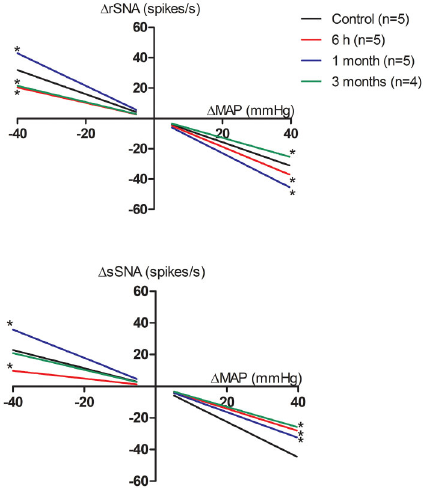
Figure 2. Analysis of the renal and splanchnic sympathetic re fl ex responses at 6 h, 1 month, and 3 months post-sepsis under vasoactive drug-induced hypotension and hypertension states. rSNA: renal sympathetic nerve activity; sSNA: splanchnic sympathetic nerve activity; MAP: mean arterial pressure. Data are reported as means ± SE. *P o 0.05 compared with control (one-way ANOVA followed by the Newman-Keuls post hoc test).